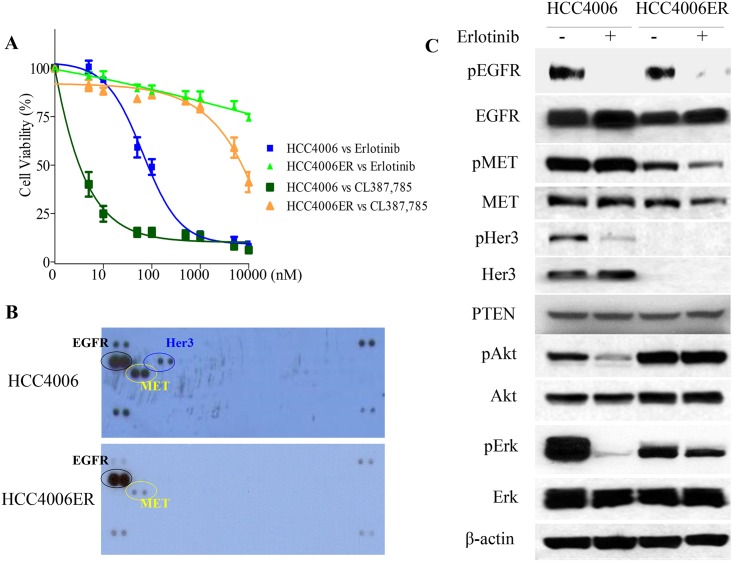
Characterization of HCC4006ER cells, which are highly resistant to erlotinib or the irreversible EGFR-TKI CL387,785.A, HCC4006 and HCC4006ER cells were treated for 72 hours with increasing concentrations of erlotinib or CL387,785. Data generated by cell viability assay (CellTiter-Glo) are expressed as a percentage of the value for untreated cells. The error bars represent SEM of 3 independent experiments. B, HCC4006 and HCC4006ER cells were incubated for 24 hours at ~80–90% of cell confluence. Whole cell lysate of each cell line was collected and subjected to Proteome Profiler Human Phospho-RTK Array Kit to examine the phosphorylation levels of multiple RTKs. Detected phospho-RTKs on the array are circled. The spots in the four corners of the RTK array are positive controls. C, HCC4006 and HCC4006ER cells were incubated for 6 hours ± erlotinib (1 μM). Cell lysates were subjected to protein expression analysis with antibodies to pEGFR, EGFR, pMET, MET, pHer3, Her3, PTEN, pAkt, Akt, pErk, Erk, and β-actin.